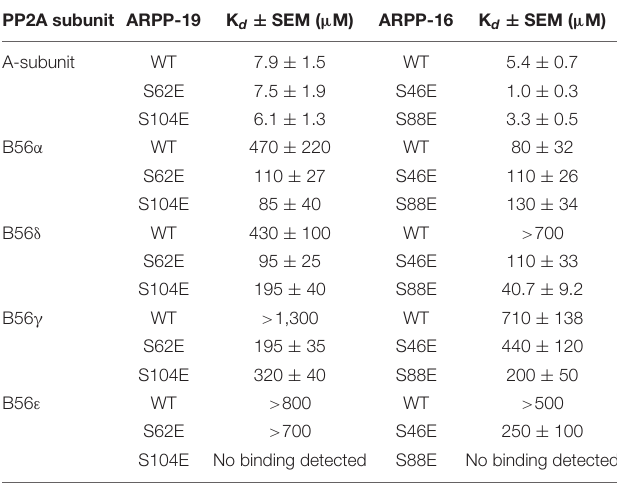
TABLE 1 | The binding affinities between ARPP-16/19 and PP2A A- and B56-subunits determined using MST. PP2A subunit ARPP-19 K d ± SEM ( µ